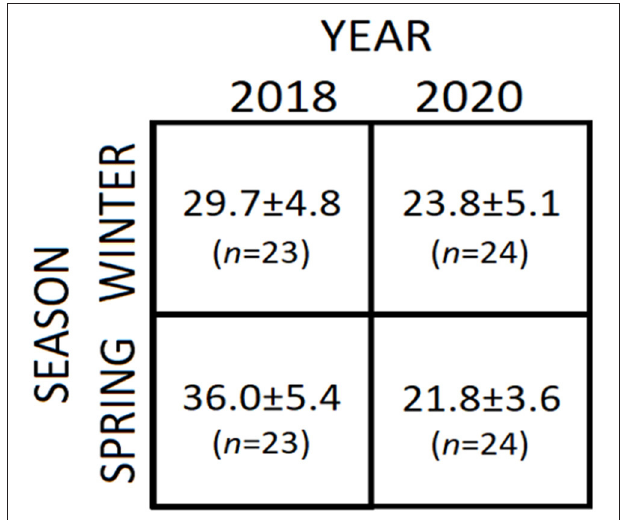
FIGURE 1 | Chronological and seasonal variations of 25(OH)D in the serum from professional football players were published elsewhere ( 18). The values represent the means ± standard deviations (in ng/ml) and the number of participants ( n